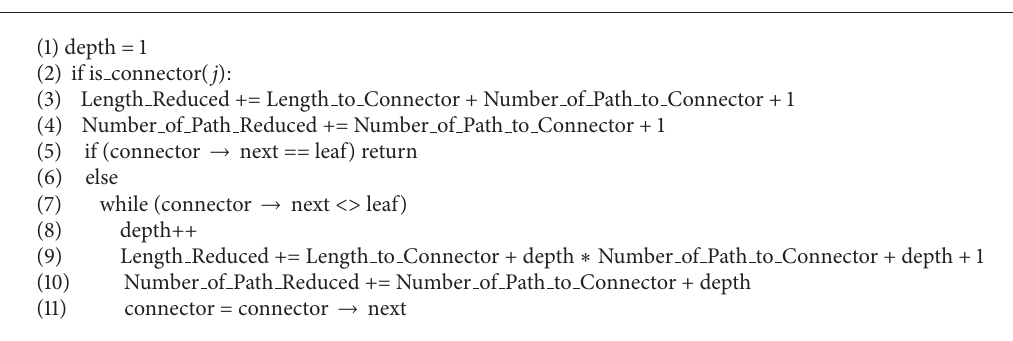
Algorithm 1: Calculate the ASPL of 𝐺 from the simplified graph 𝐺 󸀠 .